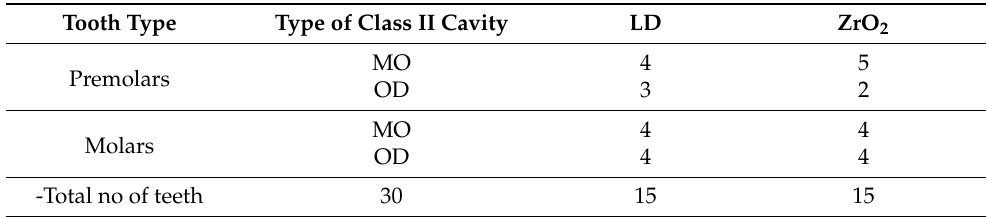
Table 2. The Class II mesio-occlusal (MO) and occluso-distal (DO) cavity distribution within study